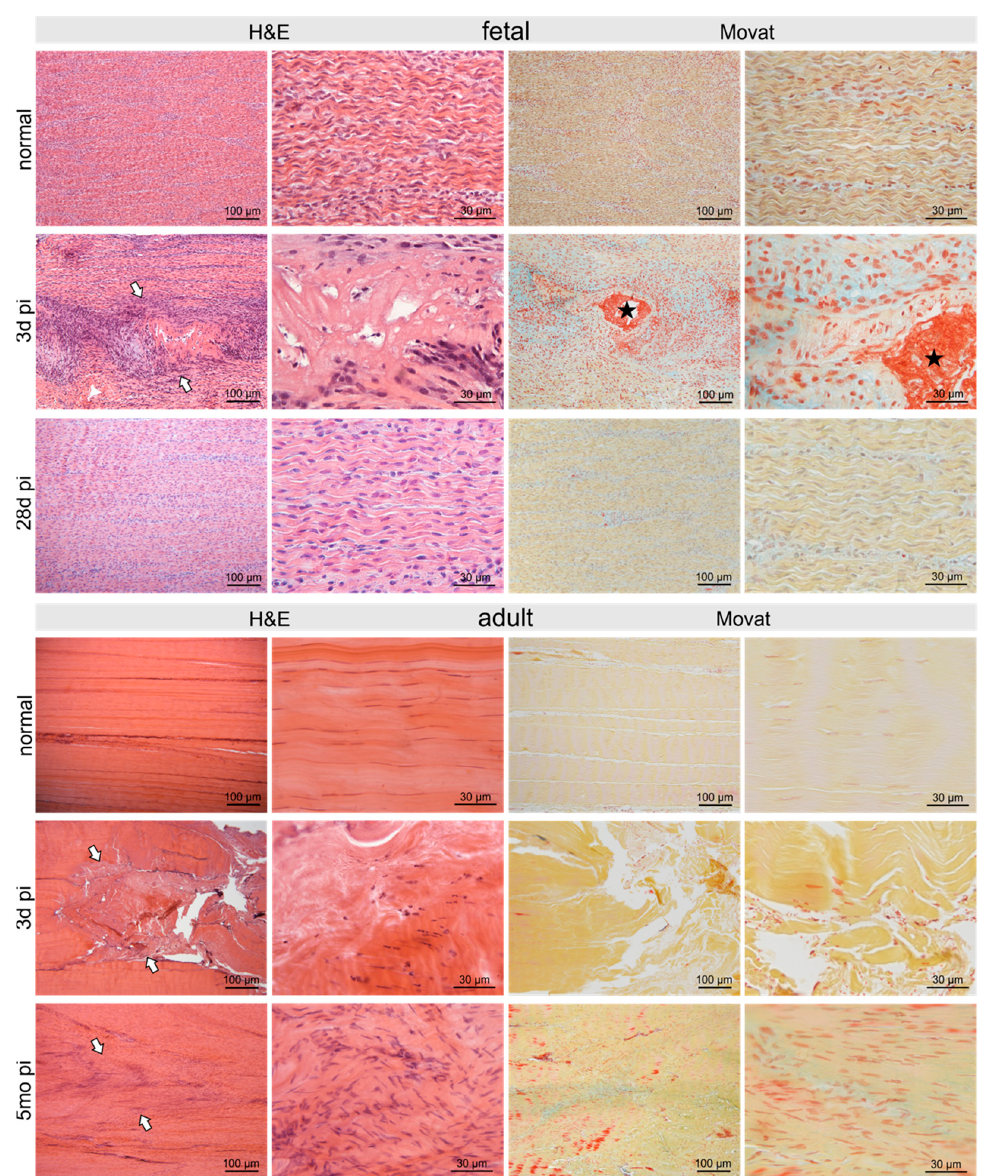
Figure 2. Micrographs show H&E ‐ and Movat ‐ stained normal control fetal and adult tendons and tendons after three days and 28 days/5 months post ‐ injury (pi), respectively. The defect was clearly seen (arrows) after three days with comparable signs of damage in adult as well as fetal tendons: disruption of regular collagen fiber arrangement, acellular areas alternating with areas of hypercellularity. Fibrin deposition (asterisk) between damaged collagen fibrils was shown by Movat staining in fetal tendons only. Five months pi the damage was still clearly visible in the adult tendon (arrows) with hypercellular areas and irregular arrangement of collagen fibers as well as tenocytes. In contrast, in the fetal tendon, no signs of the previous injury were detectable after 28 days.